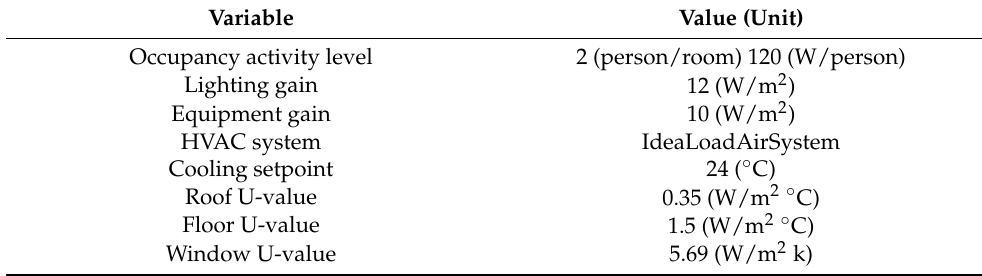
Table 2. Building parameter